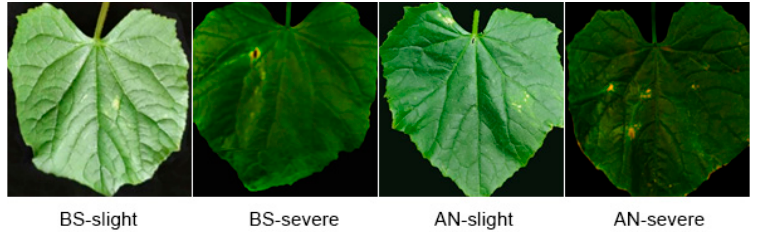
Figure 6. RGB imagines of slight and severe diseased cucumber plant diseases (BS and AN represent the brown spot and anthracnose).